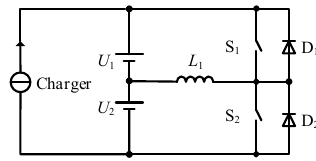
Figure 1. Integrated individual cell equaliser.